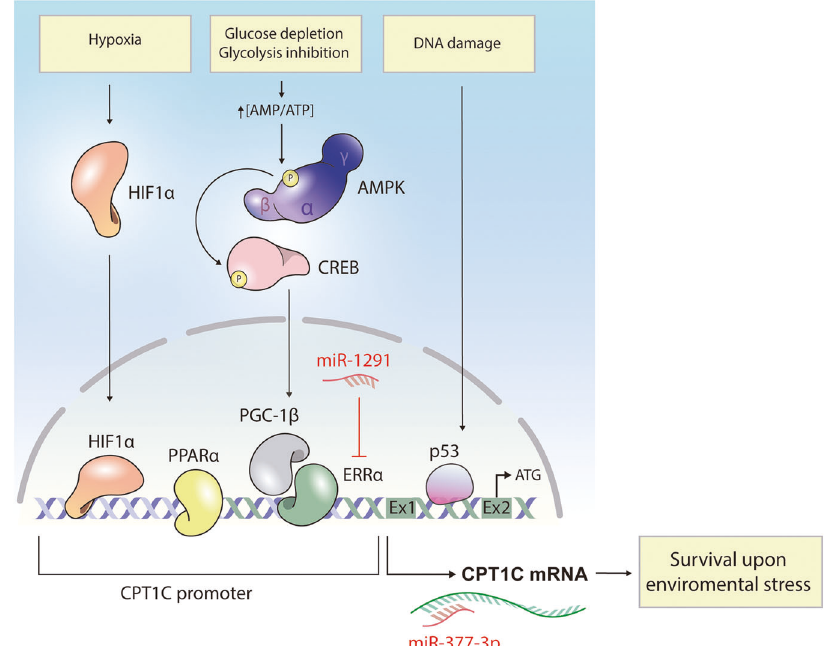
Fig. 2 Regulation of CPT1C expression. Metabolic challenges such as hypoxia and nutrient deprivation increase CPT1C expression in most cancer cells, promoting metabolic adaptation and survival in response to these environmental stressors. On the one hand, low oxygen levels promote accumulation of the HIF1 α transcription factor, which is translocated to the nucleus to bind the Cpt1c promoter and activate gene transcription. On the other hand, glucose depletion and glycolysis inhibition increase the AMP/ATP ratio leading to activation of AMPK, which in turn, phosphorylates and activates the CREB transcription factor. Phosphorylated CREB increases expression of the PGC-1 β and ERR α transcription factors, ultimately promoting Cpt1c transcription. PPAR α activates CPT1C expression by binding directly to the promoter region. p53 is activated by DNA-damaging stimuli and binds to the fi rst intron of the Cpt1c , thereby enhancing CPT1C expression. Interestingly, 2 different miRNAs have been described that downregulate this signaling pathway, one acting on ERR α expression, and the other on CPT1C